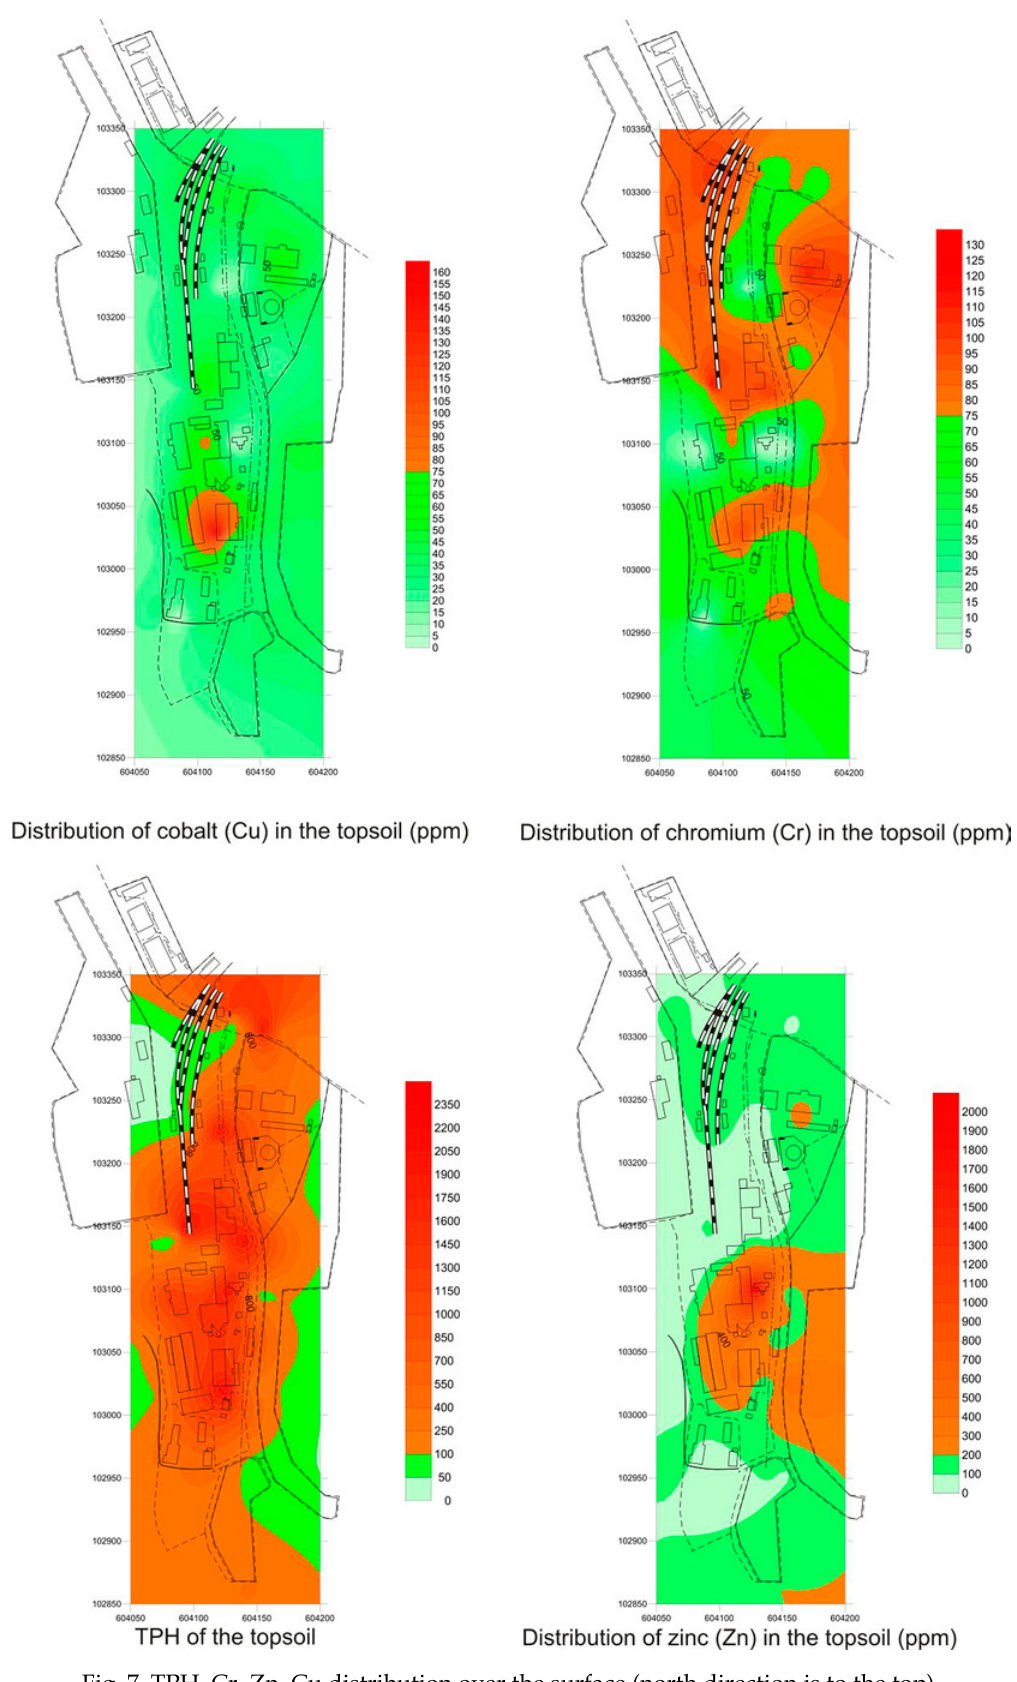
Fig. 7. TPH, Cr, Zn, Cu distribution over the surface (north direction is to the